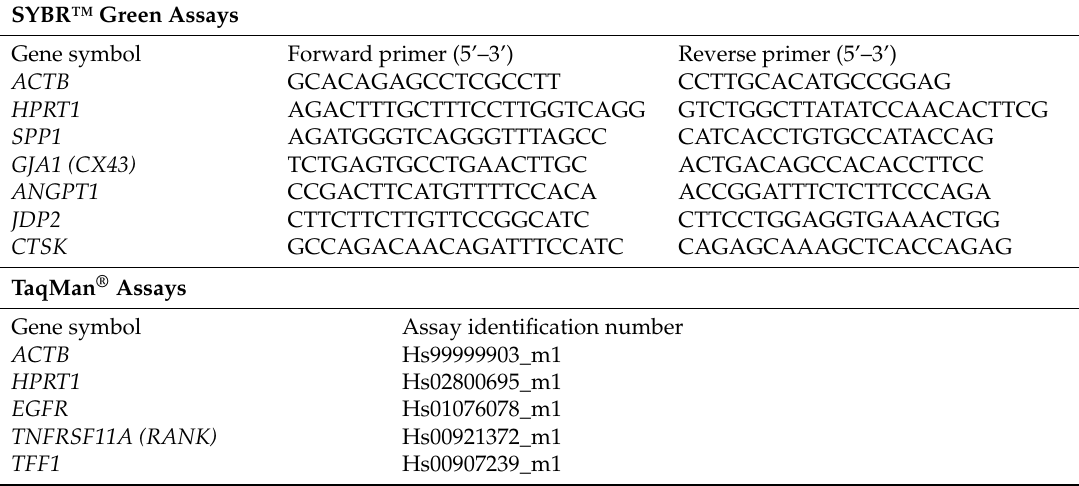
Table 2. Primers and